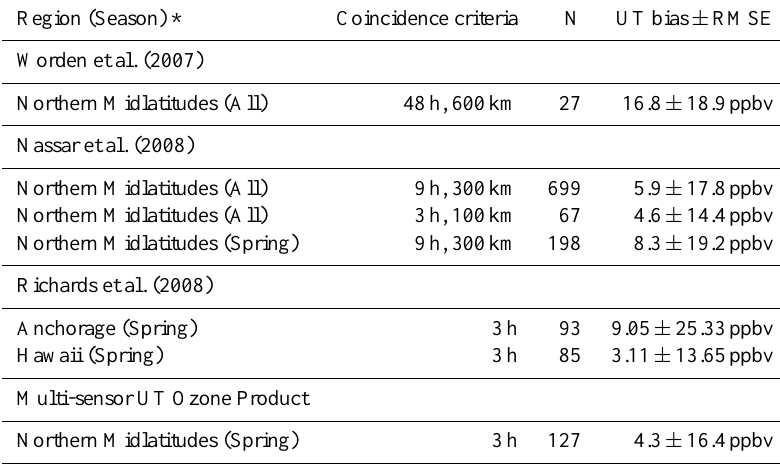
Table 3. Comparison of study results to past TES validation study results. Region (Season)